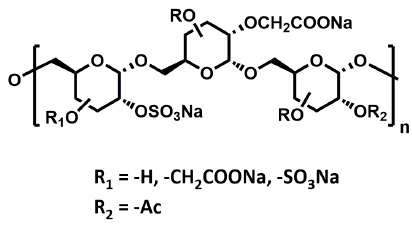
Figure 6. Chemical structure of RGTA ® .